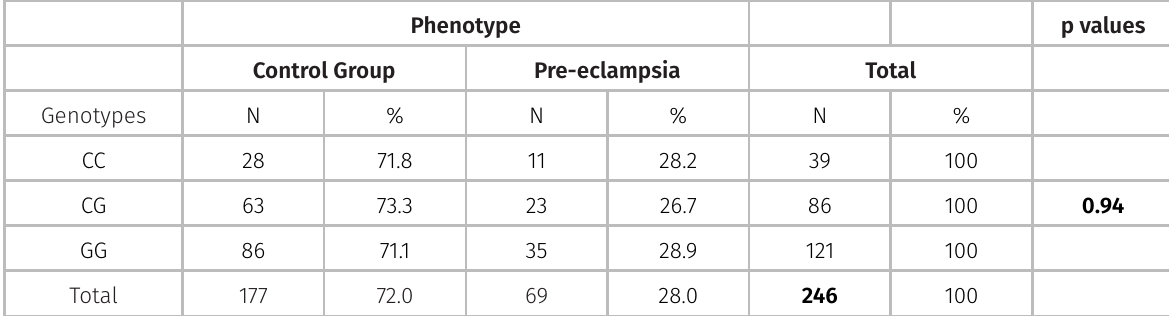
Table II. FAS (rs4064) genotypes found in women with and without